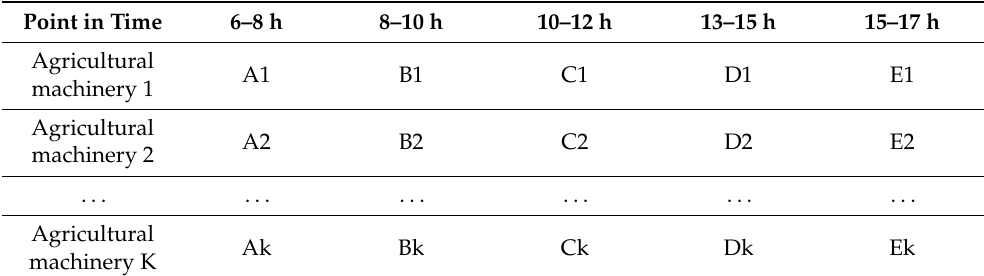
Figure 2. Schematic diagram of the agricultural machinery dynamic scheduling process. Assume that EDCBA →→→→ is the operation sequence of the first operation point in each period of the day, as shown in Table 2. Table 2. Insert position of new order.